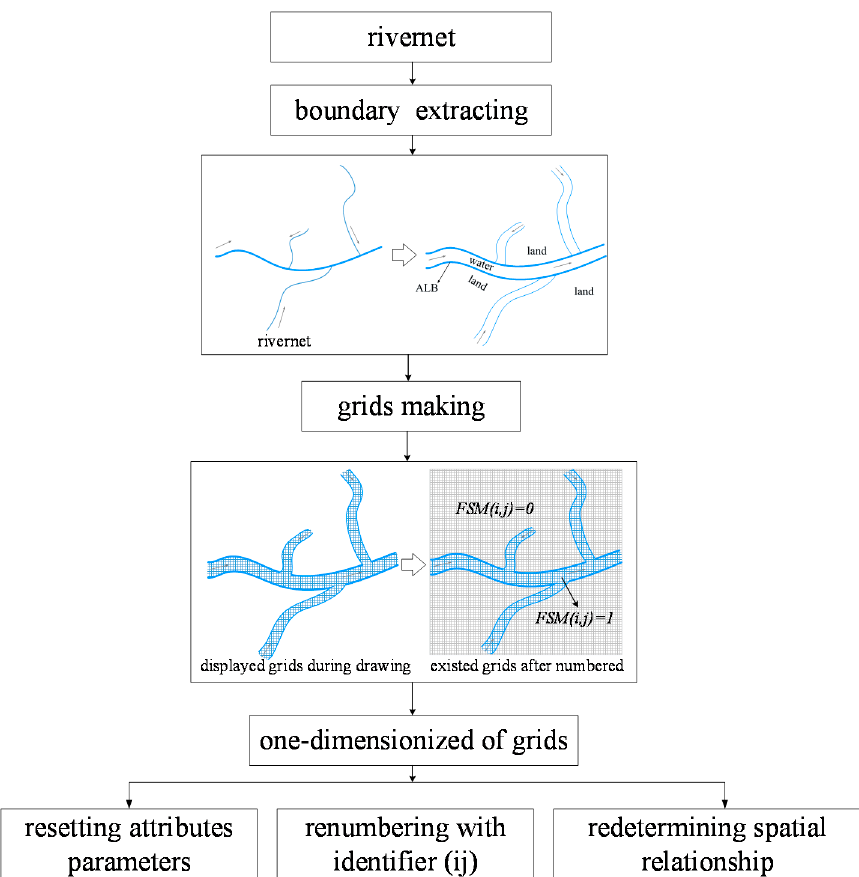
Figure 3. Framework for regular grids one-dimensioned. The ALB is absolute land boundary, over which water can never spill. The FSM is a two-dimensional mask for distinguishing water cells ( FSM(i,j)= 1) and dry cells ( FSM(i,j)=0 ).